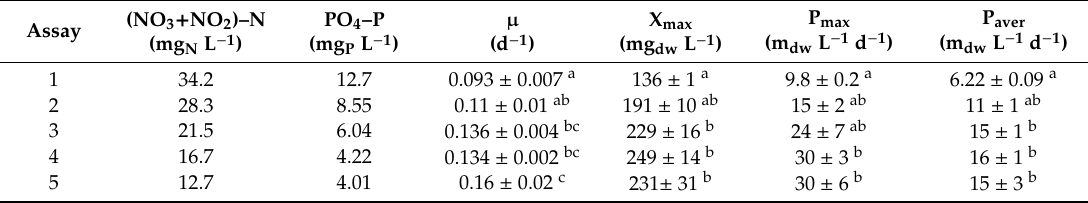
Table 2. Specific growth rates ( µ , in d − 1 ), maximum biomass concentrations ( X max , in mg dw L − 1 ), and maximum and average biomass productivities ( P max and P aver , in mg dw L − 1 d − 1 ) determined for C. vulgaris grown in raw and diluted secondary-treated paper industry e ffl